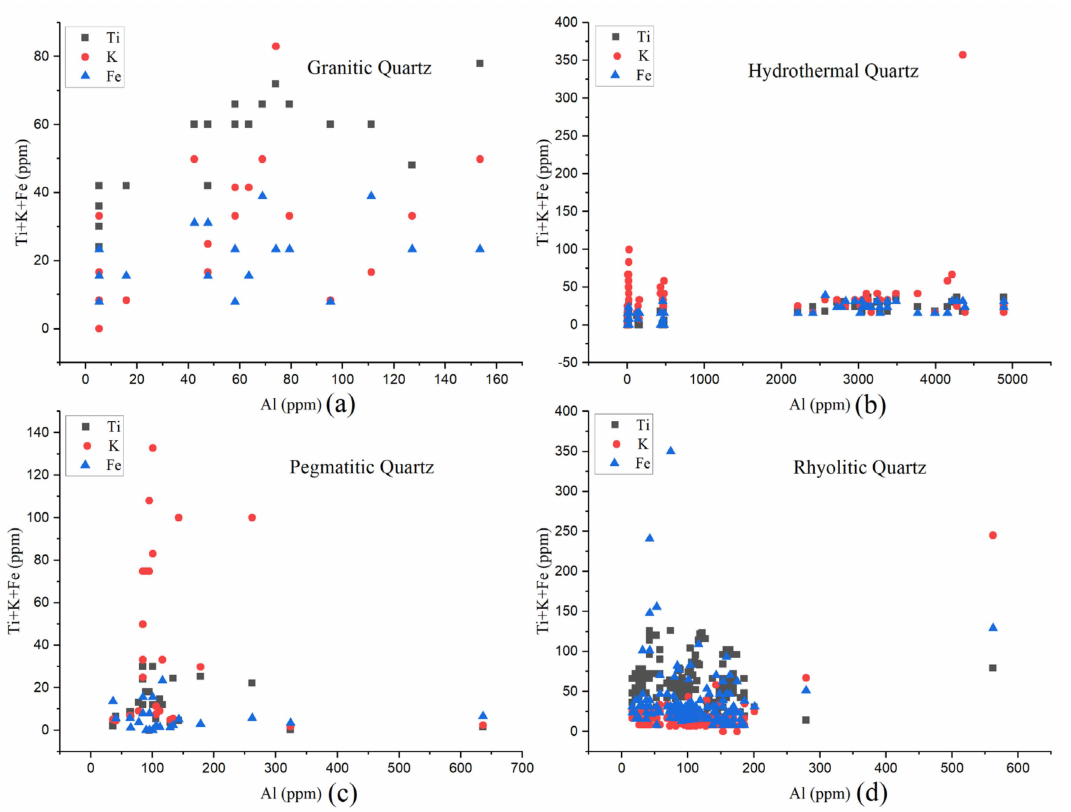
Figure 12. Representation of the concentrations of trace elements (i.e., Al vs. Ti, K, and Fe) from different ore deposits. ( a ) Trace elements correlation in granitic quartz; ( b ) hydrothermal quartz; ( c ) pegmatitic quartz; ( d ) rhyolitic